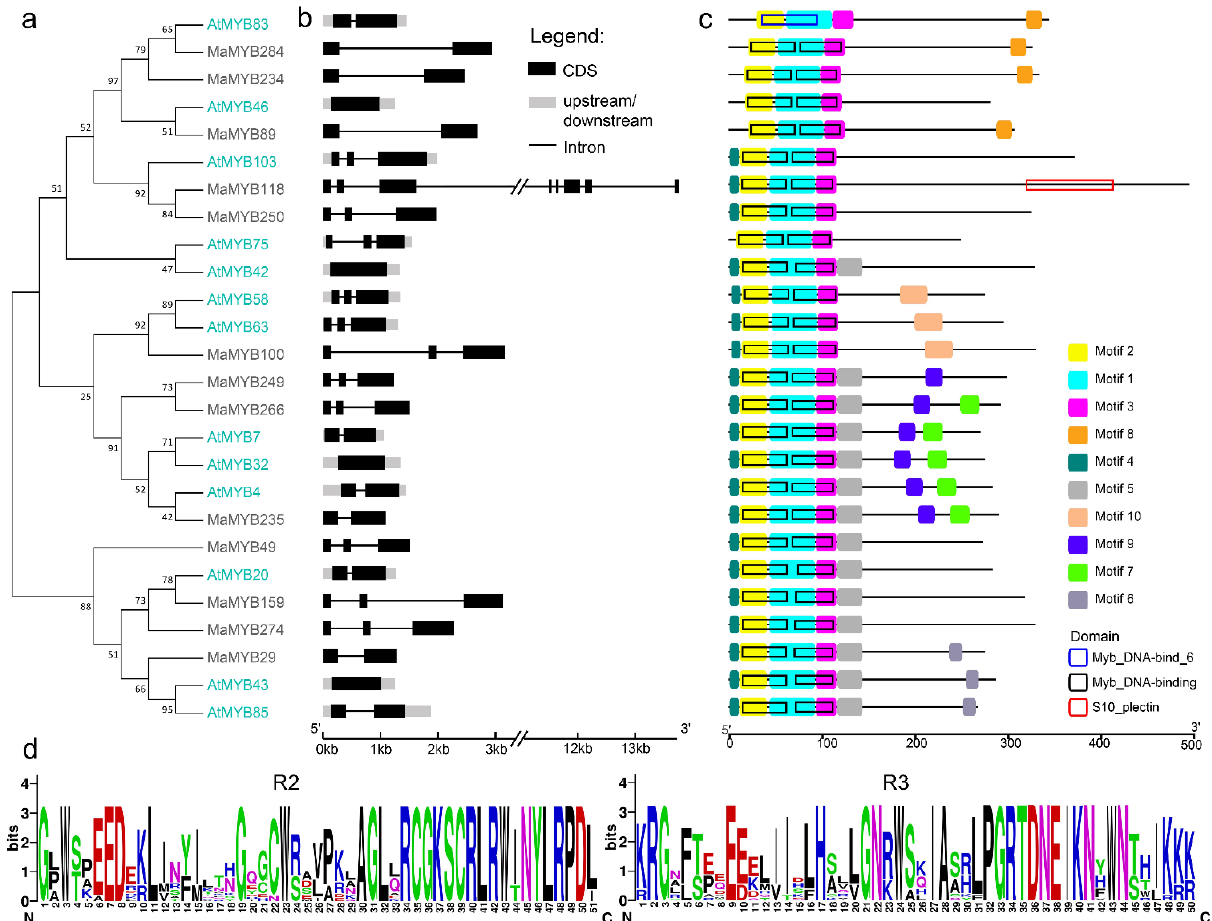
Figure 7. Phylogeny, gene structure and motif analysis of lignin biosynthesis-related MYB genes from M. albus and Arabidopsis . ( a ) Phylogenetic tree of 13 MaMYB proteins and 13 AtMYB proteins. The phylogenetic tree was constructed via MEGA, 7.0 with the maximum likelihood method. The bootstrap test was performed with 1000 replicates. ( b ) Intron/exon structures of M. albus and Arabidopsis MYB genes. ( c ) M. albus and Arabidopsis MYB protein motifs and the positions of the R2 and R3 Myb domains. ( d ) Sequence logo of the Myb domain in M. albus . The bit score represents the information content for each position.